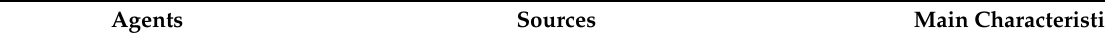
Table 1. Main characteristics of parabens, triclocarban, and